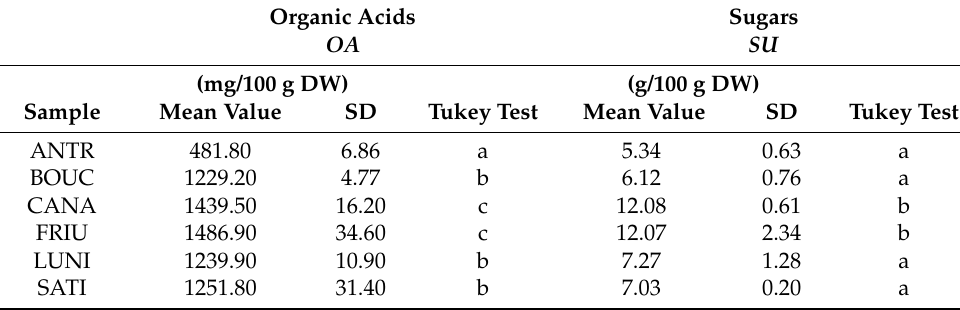
Table 3. Nutritional substances of the tested